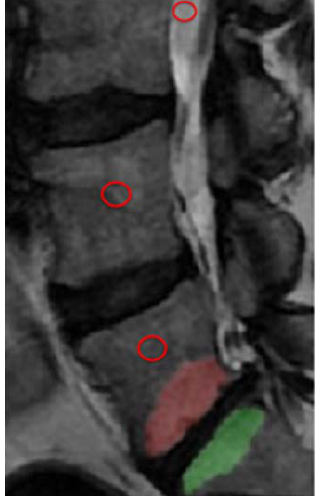
Figure 1. Illustration of Modic change (MC) segmentation in L5 and S1 and placement of ROIs (red circles) in cerebrospinal fluid, vertebrae without MC, and vertebra with MC .